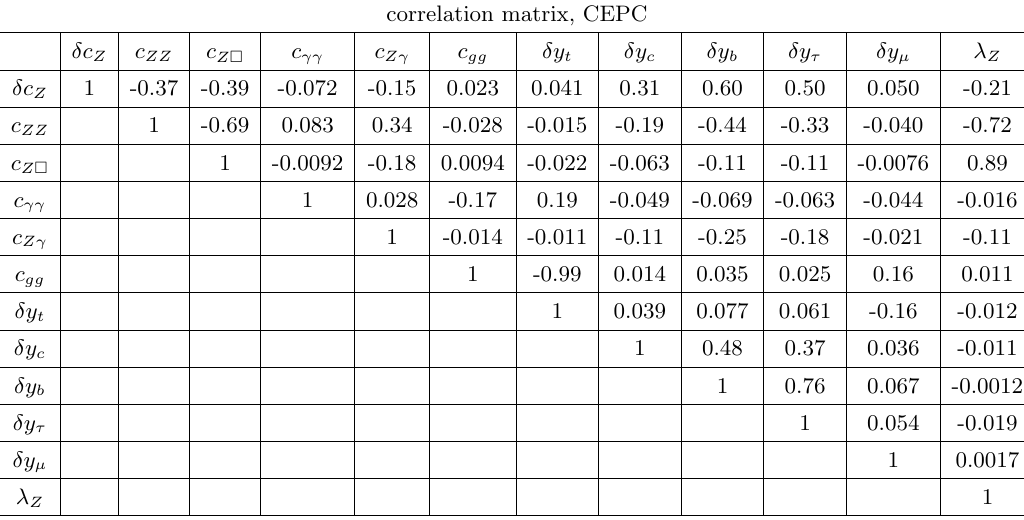
Table 12 . The corresponding correlation matrix for the CEPC one sigma bounds in table 11.